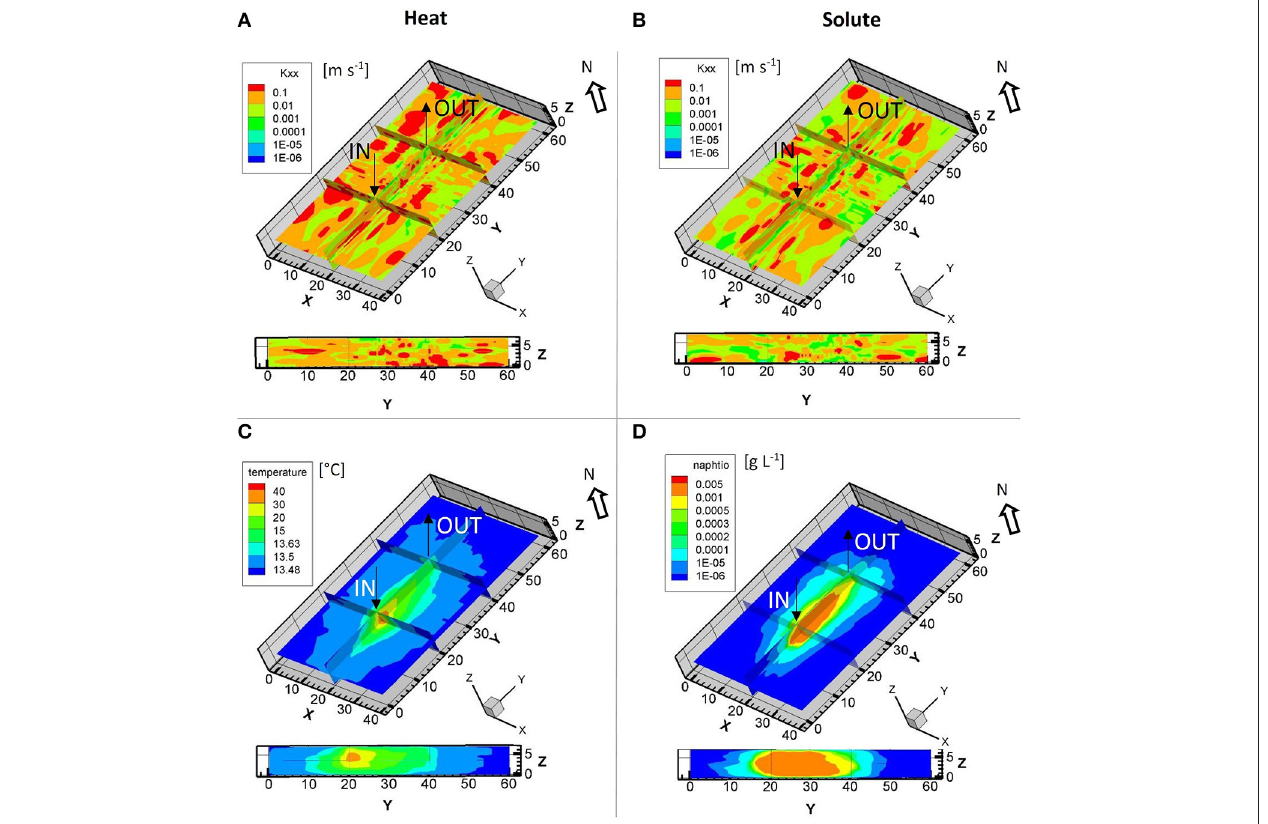
FIGURE 5 | Simulated results at the pumping well using a prior with no K-trend distribution (Scenario A): Spatial K-distribution as obtained for the picked up best simulation for (A) heat data and (B) for the best napthionate simulation. Corresponding simulated tracer plumes for best simulation for (C) heat data and (D) for napthionate data. Under each 3D visualization, a vertical 2D profile is shown along the gradient axis from the injection well through panels 1, 2, and 3, and down to the pumping